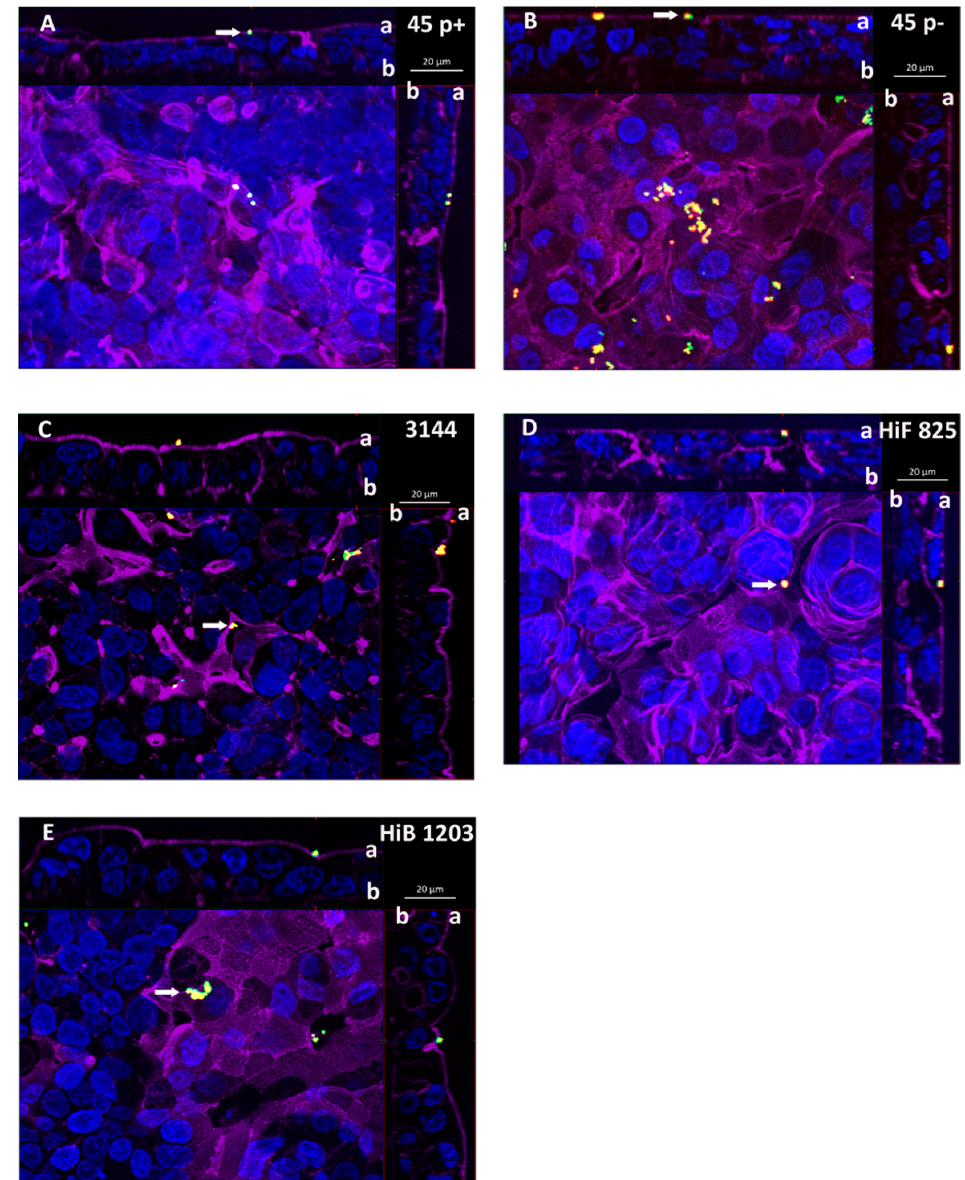
Figure 5. DIF sections of HIBCPP cells apically infected with the indicated Haemophilus strains. Cells were grown in the standard cell culture system and challenged with a MOI of 20 of: ( A ) the nasopharyngeal NTHI isolate 45 p+ (fimbriated variant); ( B ) the nasopharyngeal NTHI isolate 45 p- (non-fimbriated variant); ( C ) the NTHI CSF isolate 3144; and with the encapsulated H. influenzae CSF isolates ( D ) HiF 825 and ( E ) HiB 1203. After 6 h of infection cells were subjected to DIF staining to analyze invasion. Intracellular bacteria are visualized in green and extracellular bacteria in yellow. DAPI (blue) and phalloidin (purple) were used to stain the cell nuclei and the actin cytoskeleton, respectively. ( A – E ) Apotome images of apically infected HIBCPP cells. The center part of each panel represents the xy en face view. An overlay of selected slices through the z-axis intensifies images for presentation. The top and side part of each panel represent the cross-sections through the z-plane of slices in the overlay. In the cross sections the apical cell side facing the top and the right side, respectively, is labeled with ”a” and the basolateral cell side facing the center part is labeled with “b”. A characteristic distribution for the individual strains is represented. Almost no invaded bacteria (green) could be detected in the standard cell culture infected cells. Extracellular bacteria (yellow) adhering to the apical cell side (CSF facing side) are marked with a white arrow.